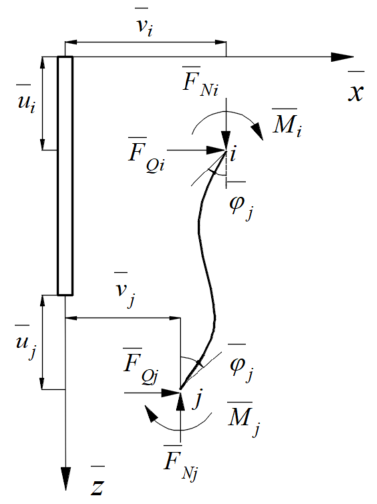
Figure A1. Element end forces and displacements.